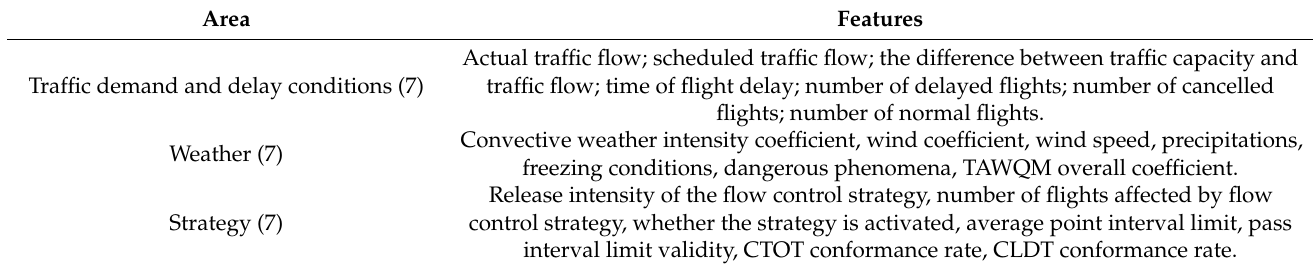
Table 1. Terminal area feature